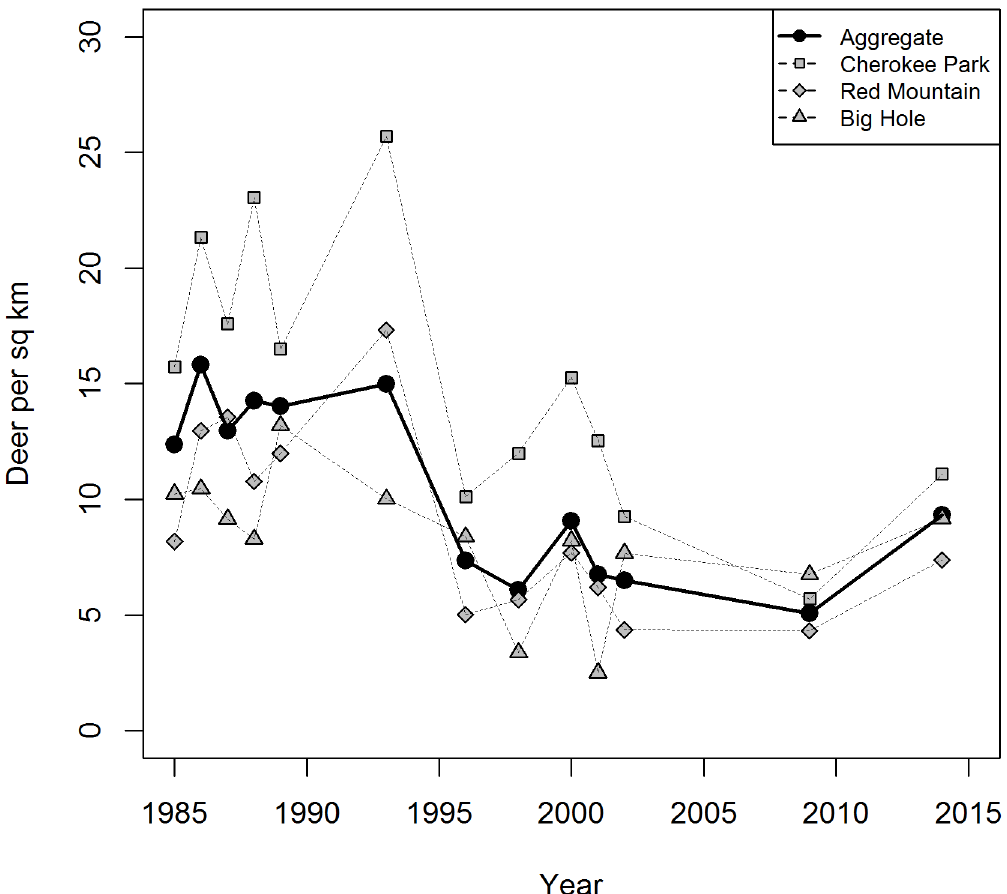
Fig 2. Average density of the deer population and individual wintering subpopulations. Average deer density (km -2 ) for the overall study area (in aggregate) and for the Big Hole, Cherokee Park, and Red Mountain wintering subpopulations during 1985 – 2014.